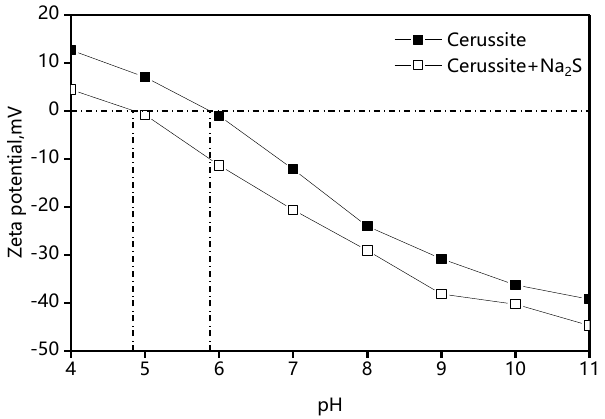
Figure 5. Zeta potential of cerussite at different pH in deionized water and sodium sulfide solution.